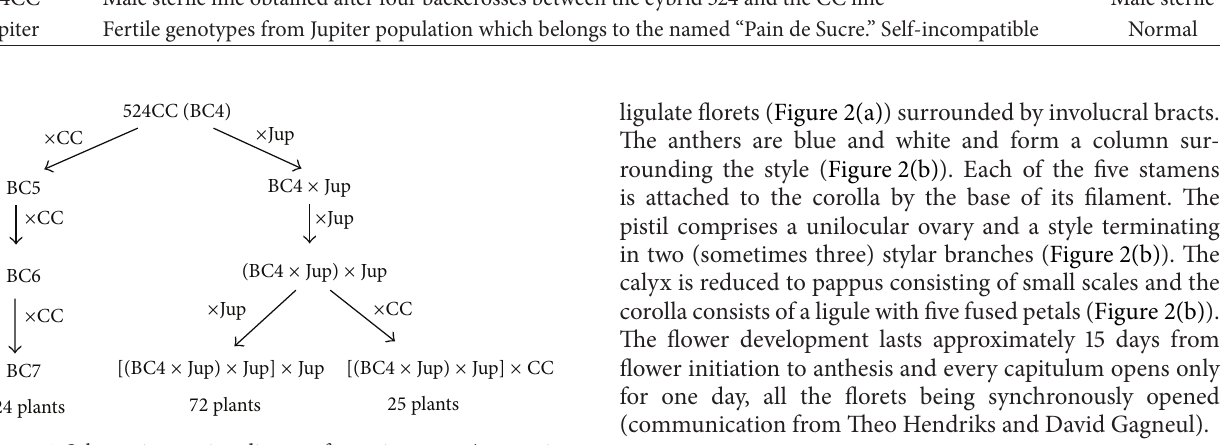
Figure 1: Schematic crossing diagram for maintenance/restoration of cytoplasmic male